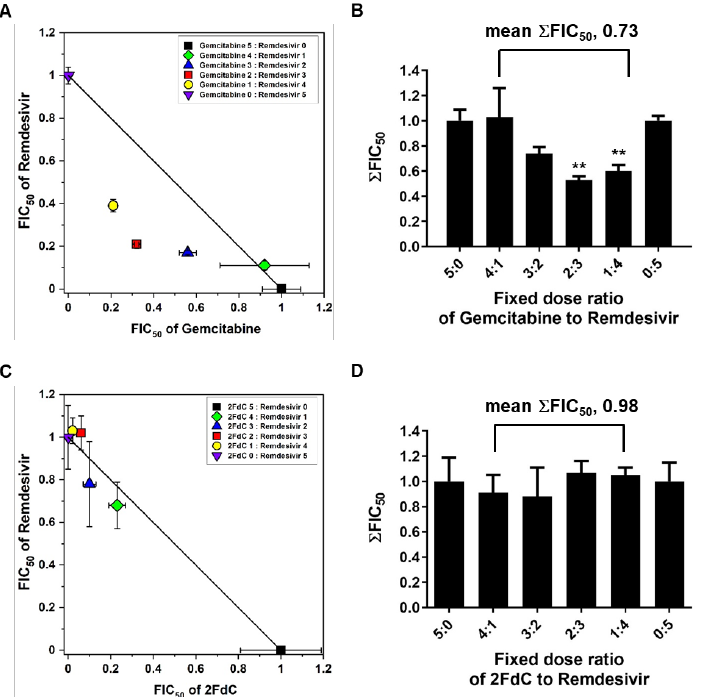
Figure 7. Synergistic effect of gemcitabine with remdesivir. ( A ) Isobologram showing the synergistic interaction between gemcitabine and remdesivir for inhibition of SARS-CoV-2 infection in Vero cells. It was plotted using the relative FIC 50 values of gemcitabine on the horizontal axis and the values of remdesivir on the vertical axis. ( B ) The sums of both FIC 50 values (ΣFIC 50 s) at the combination ratios of gemcitabine to remdesivir, 4:1, 3:2, 2:3 and 1:4, and their mean values were quantified. ( C ) Isobologram of the interaction between 2FdC and remdesivir against SARS-CoV-2 in Vero cells. ( D ) The sums of both FIC 50 values (ΣFIC 50 s) at the fixed combination ratios of 2FdC to remdesivir, 4:1, 3:2, 2:3 and 1:4, and their mean value were quantified. Values are means ± standard deviations from thee three independent experiments. ** p < 0.01.